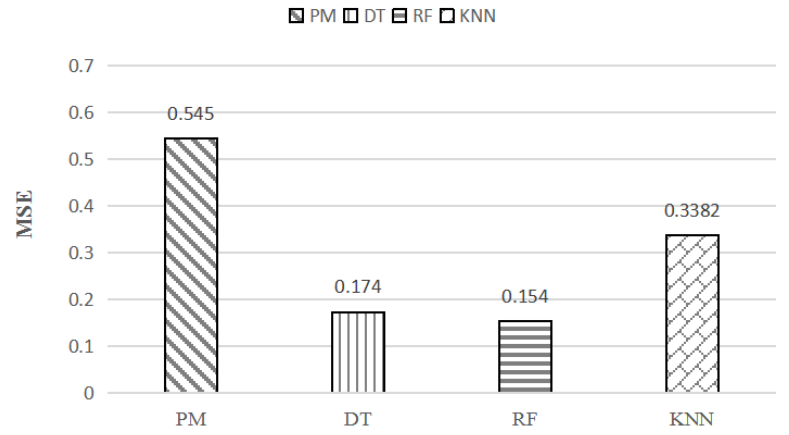
Figure 8. MSE values of polynomial regression (PM), decision tree (DT), random forest (RF) and